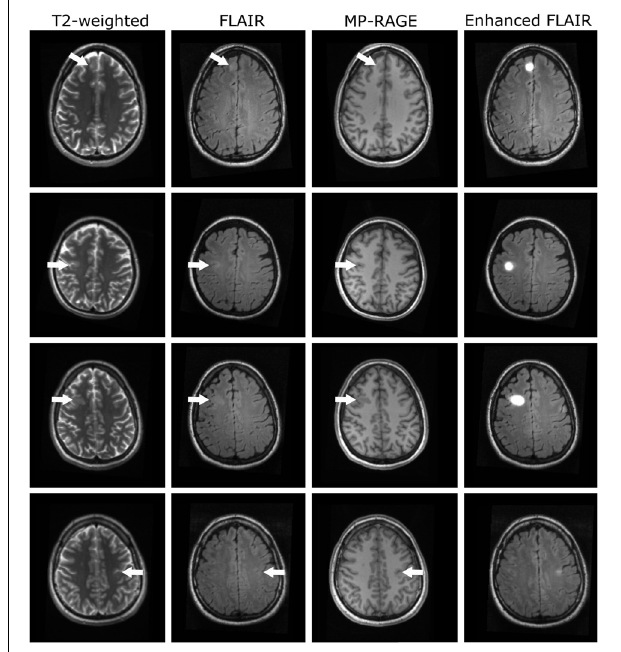
FIGURE 3 | Representative datasets of four patients with FCD (rows). From left to right: T2-weighted, FLAIR-, MP-RAGE- and enhanced FLAIR-datasets. Arrows indicate the locations of the